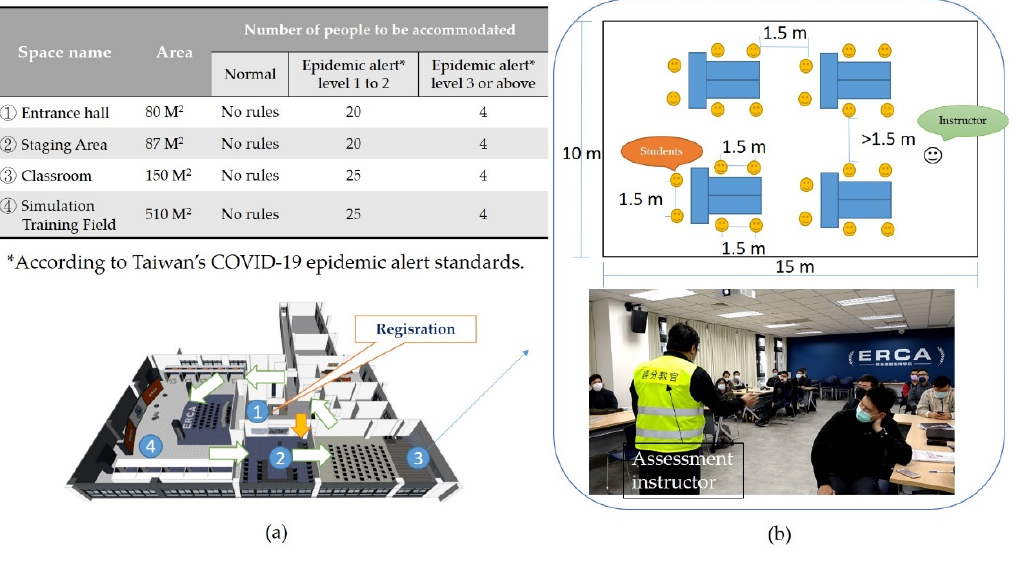
Figure 4. ( a ) Adjust the students’ movement sequence (1 > 2 > 3 > 4) according to the epidemic control measures and limit the number of people in each classroom according to the development stage of the epidemic. ( b ) For teaching classrooms, students are required to sit 1.5 m apart and wear masks during epidemic alert levels 1 to 2. C1 courses above alert level 3 will be changed to online courses, but VRST will be conducted